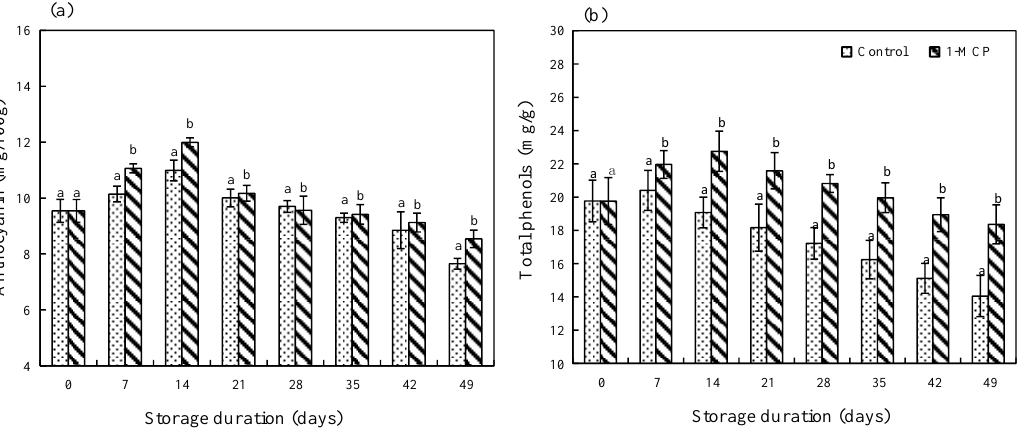
Figure 6. Effects of 1 − MCP treatment on anthocyanin and total phenols contents of “Dianhong” rose petals in different storage periods: ( a ) Effect of 1 − MCP on anthocyanin content; ( b ) Effect of 1 − MCP on total phenols content. Different letters on the bar chart indicate significant differences among group ( p < 0.05, n =